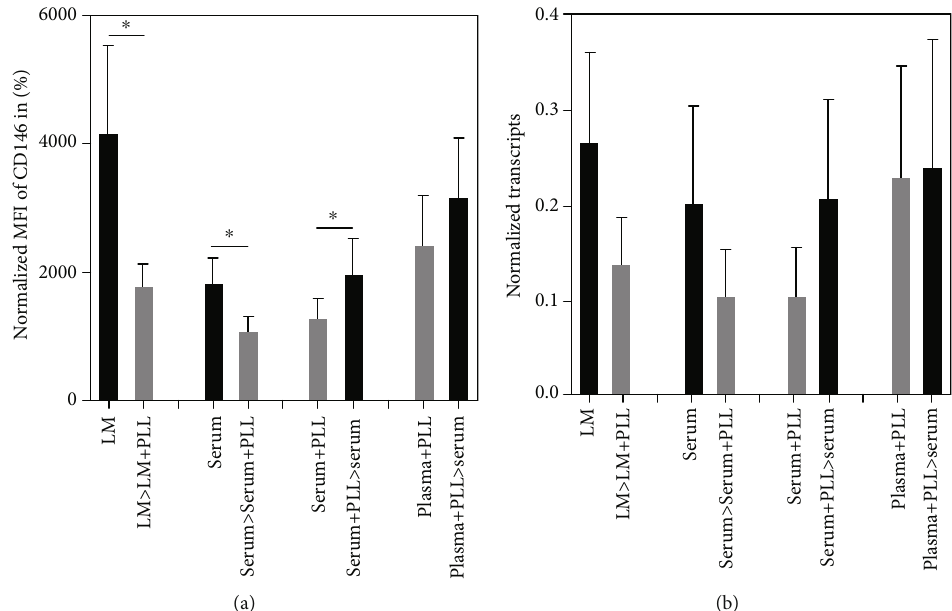
Figure 2: E ff ect of PLL on the CD146 expression. The pMSCs were expanded to their second passage in medium as indicated, split, and expanded further for 7 days in the same medium (i.e., LM, serum, serum+PLL, plasma+PLL) or in medium either enriched ( > LM +PLL, > serum+PLL) or deprived from PLL ( > serum, > serum). (a) The average of CD146 mean fl uorescent intensities (MFI) dropped in all experiments when pMSCs were further cultured in medium complemented with PLL (grey bars), while it increased, when pMSCs were further cultured in medium deprived from PLL (black bars). The bars show the meanMFI ± standard deviation from pMSCs of 5 donors. (b) Messenger RNA amounts were enumerated by qRT-PCR in pMSCs expanded in medium either complemented with PLL (grey bars) in comparison to medium without PLL (black bars). In all cases investigated, addition of PLL reduced CD146 transcript amounts, while reduction of PLL from expansion in serum+PLL to serum only caused an increase in CD146 transcripts. The change from plasma+PLL to serum had no e ff ect on CD146 transcript amounts. The bars show the mean normalized transcript amounts from pMSCs of 3